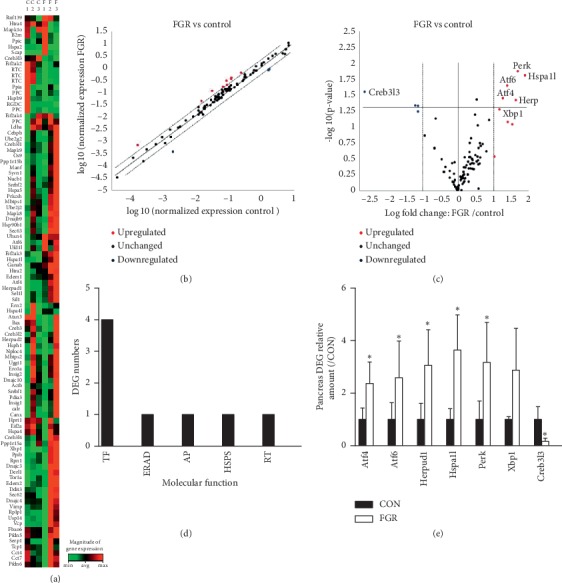
Expression of unfolded protein response- (UPR-) related factors in the FGR fetal pancreas, as determined by qPCR arrays. (a) K-means clustering representation of eighty-four mRNA profiles. The magnitude of the change is represented by a color scale (top right) from low (green) to high (red). b and c indicates scatter plot and volcano plot displaying differentially expressed genes in pancreatic tissues between two groups (n = 3). (b) The x and y axis, respectively, indicate the mean expression value of control and FGR after log10 transformation. (c) The y-axis indicates the p value after log10 transformation, and the x-axis displays the log2 fold change (FC) value (FGR/control). Red dots represent upregulated transcripts (FC > 2); blue dots represent downregulated transcripts; black dots represent unchanged transcripts (0.5 < FC < 2). (d) Differentially expressed genes divided into 5 categories according to molecular function. TF, transcription factor; ERAD, endoplasmic reticulum-associated degradation; AP, apoptosis, HSPs, heat-shock protein; RT, regulation of translation. (e) Differentially expressed genes between two groups (n = 3 per group; ∗p < 0.05 vs. control, unpaired Student's t-test).